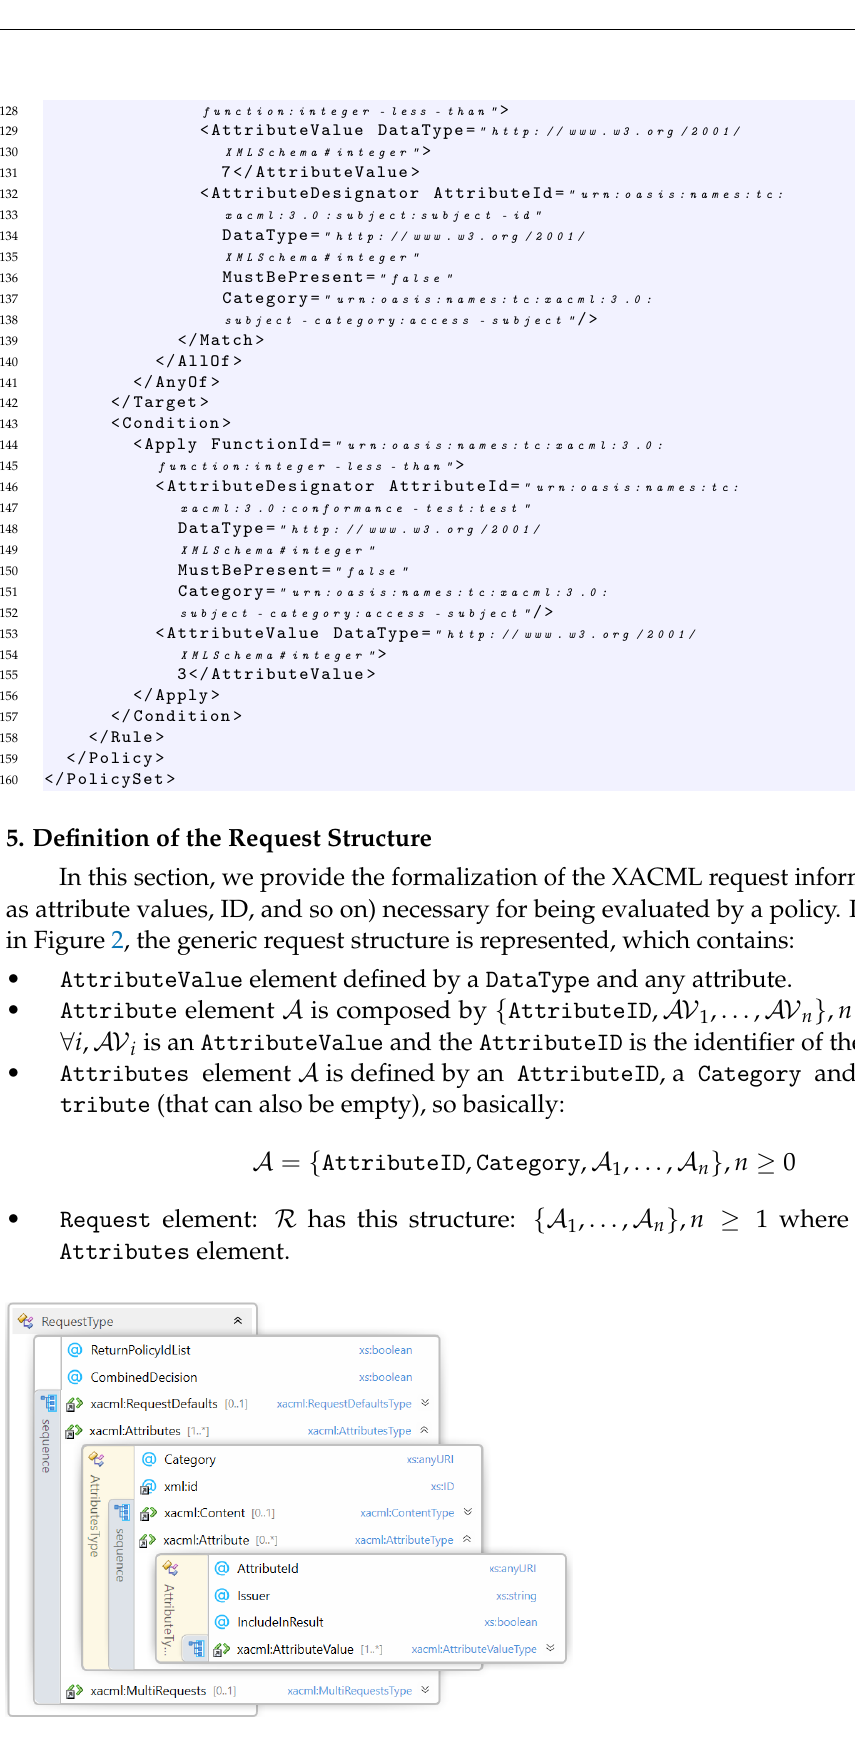
Figure 2. Request